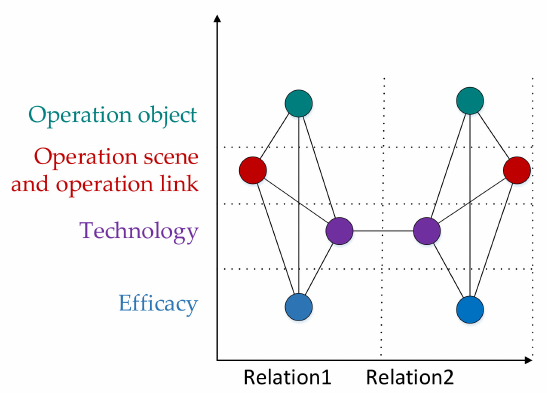
Figure 6. The agricultural robot design TKG.